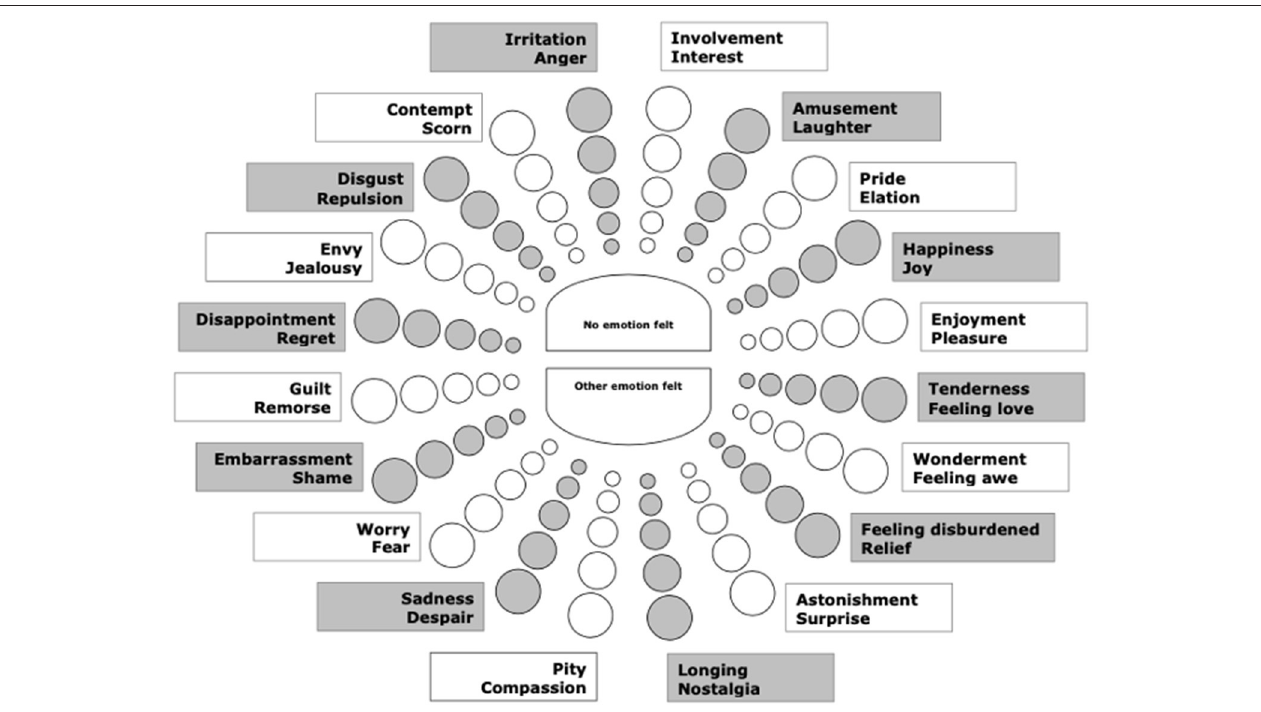
FIGURE 1 | The Geneva Emotion Wheel (GEW, reproduced with permission from Scherer, 2005; Scherer et al.,